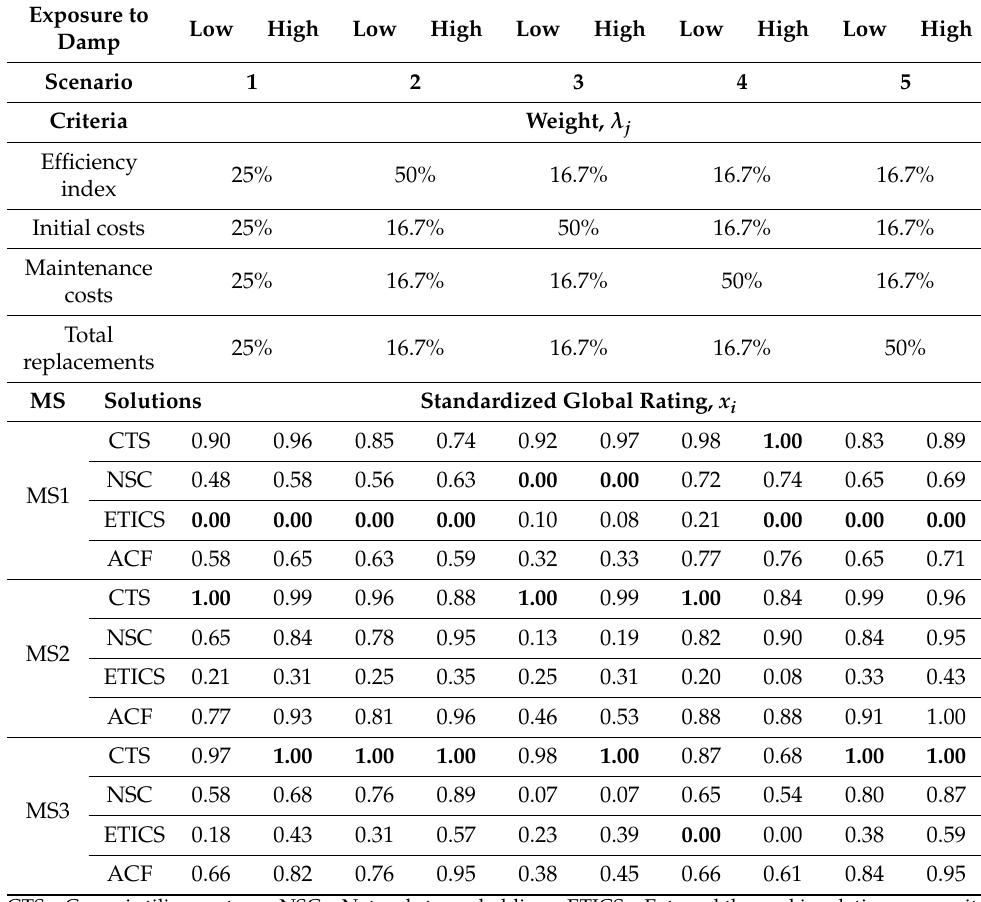
Table 4. Multi-criteria decision analysis for the exposure to damp.